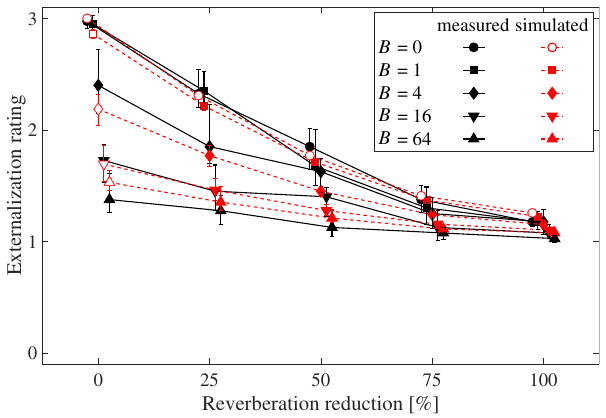
Figure 7. Median values of externalization ratings and the model predictions for different bilateral spectral smoothing ( “ B ” ) and reverberation reduction levels across subjects. All other conventions are as in Figure